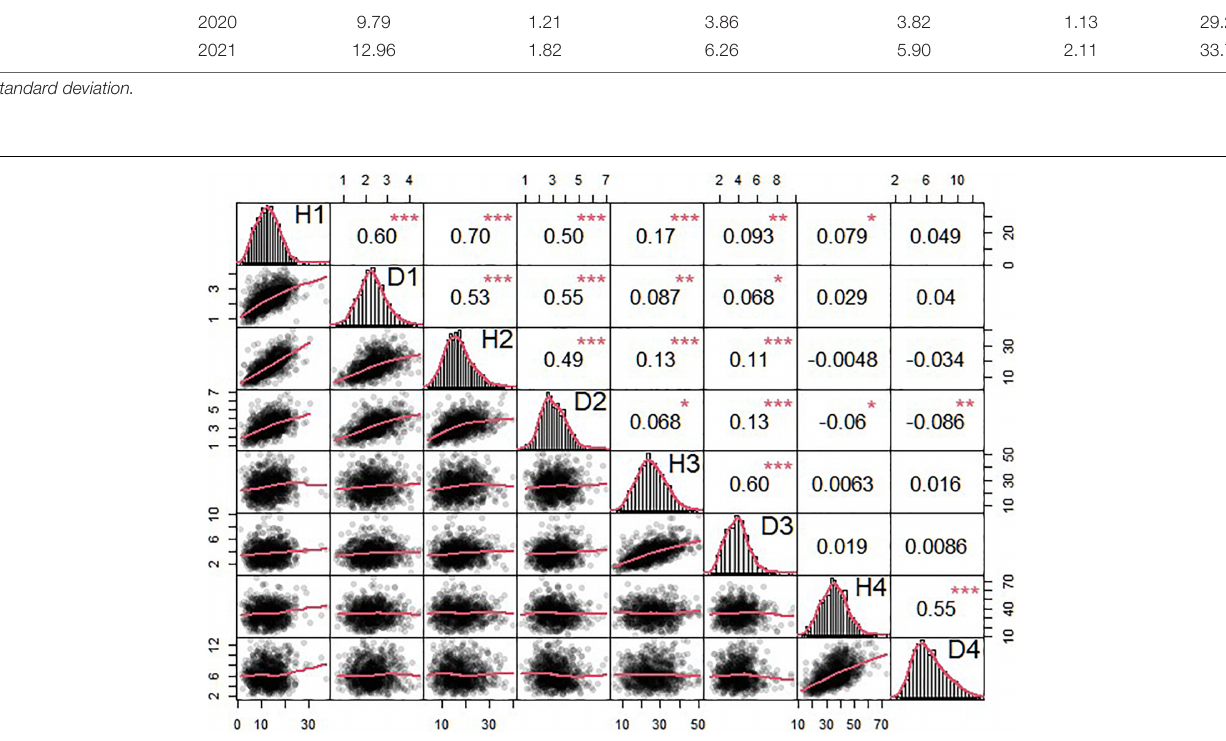
Frontiers in Plant Science |